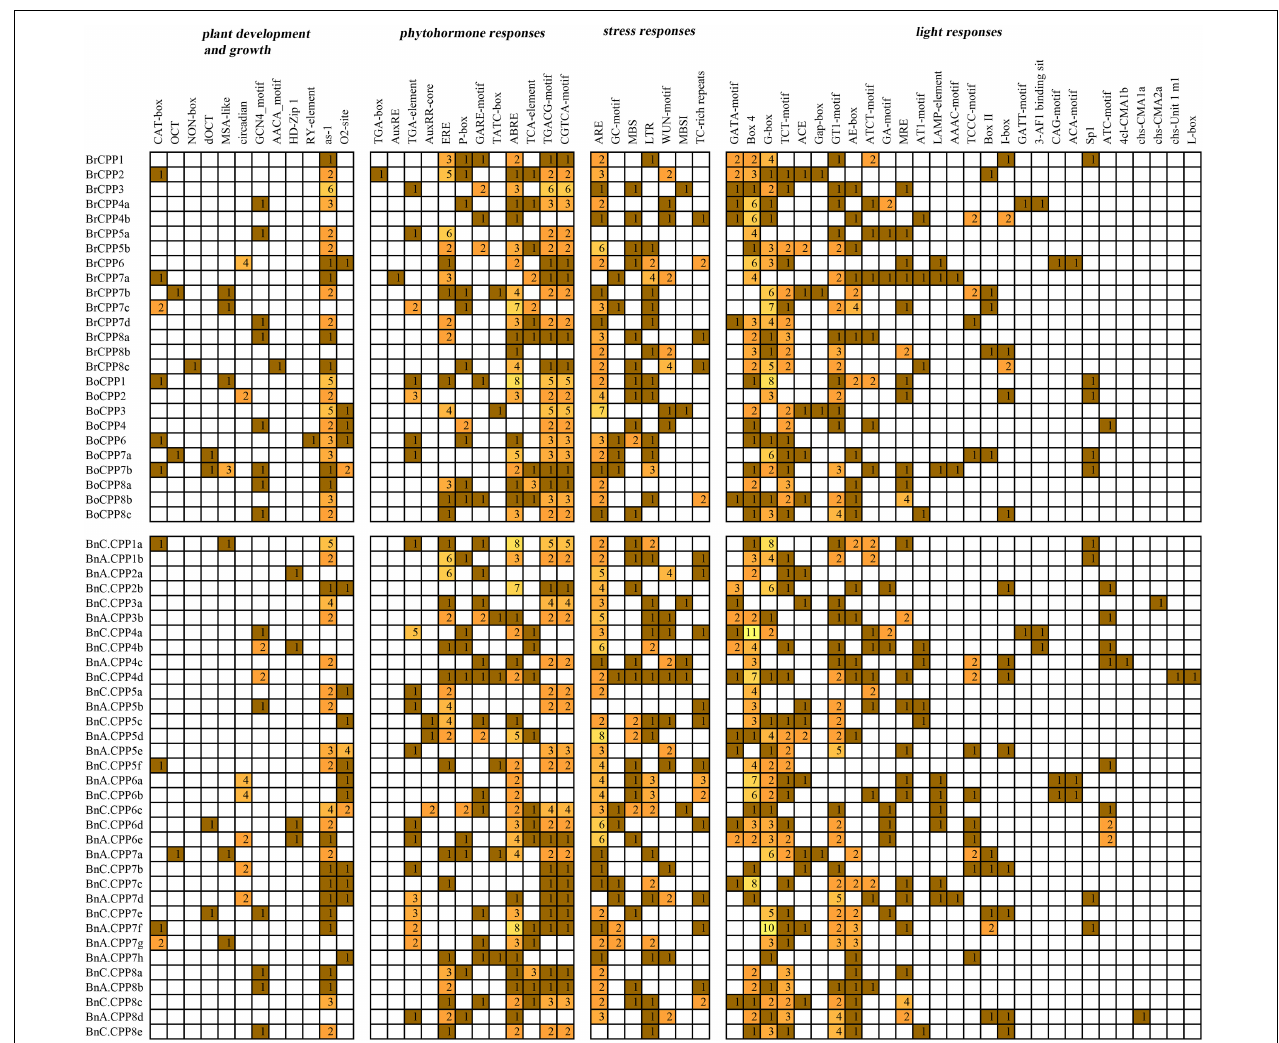
FIGURE 5 | Cis -acting elements on promoters of CPP genes from B. napus and diploid progenitors.